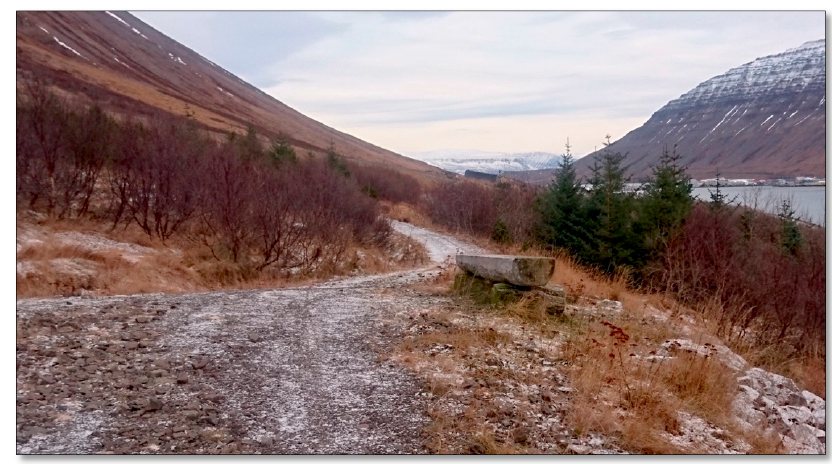
Figure 6. Forest site below Skíðavegur.